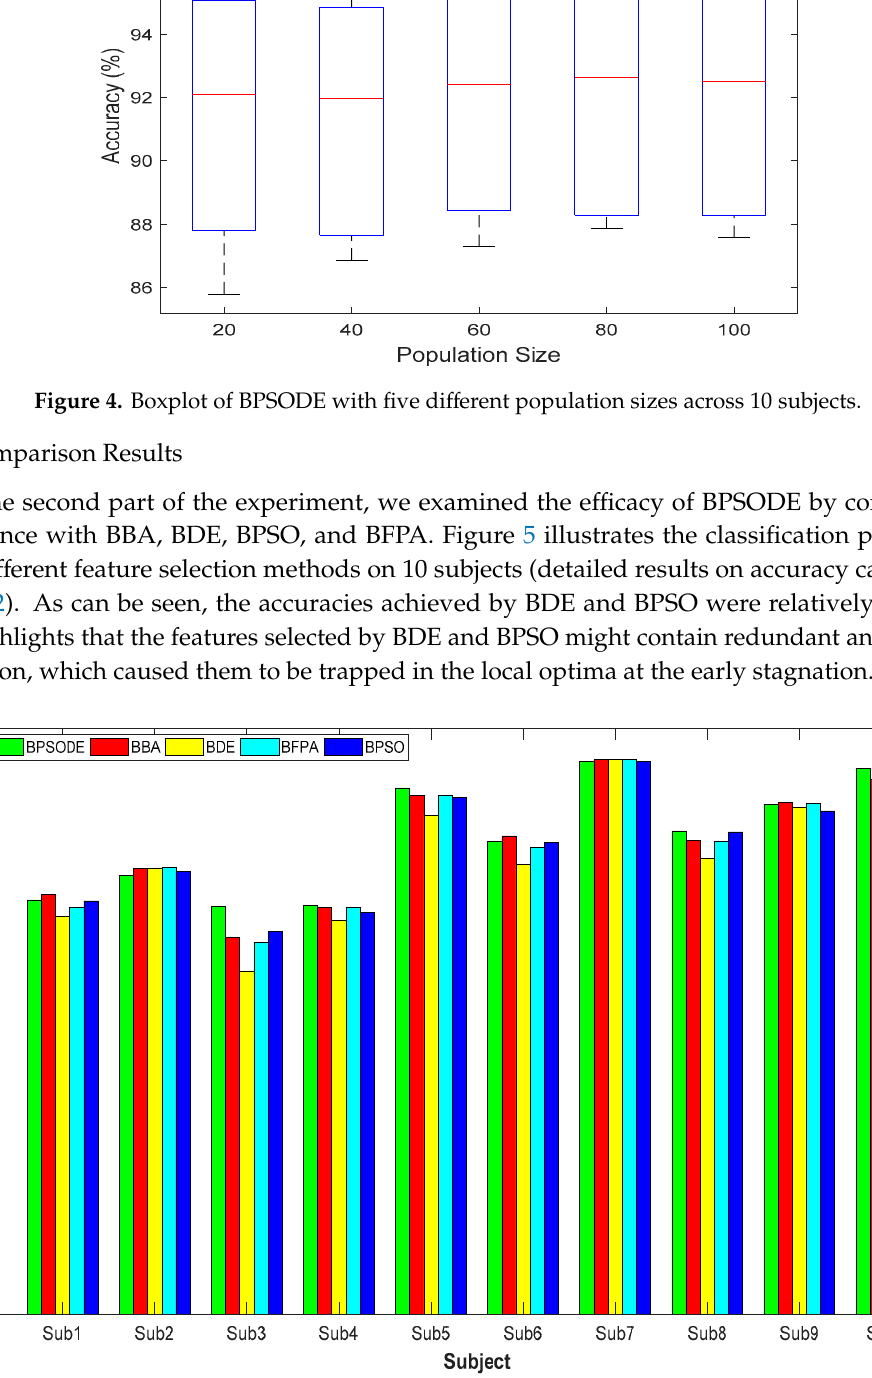
Figure 5. Accuracy of the five di ff erent feature selection methods on 10 subjects.